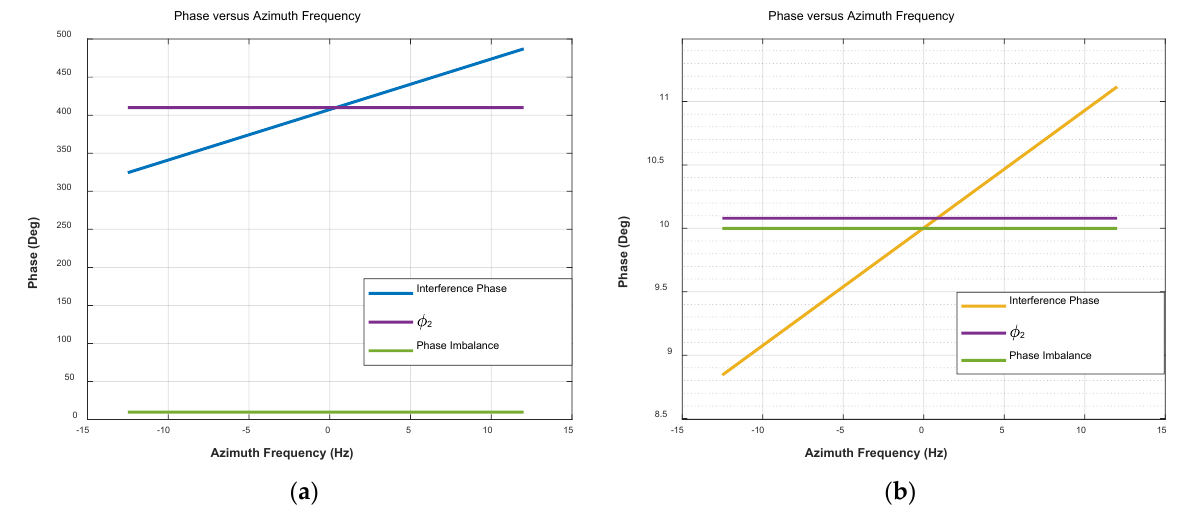
Figure 3. The phase imbalance estimation results by FCM before and after the Doppler centroid compensation, where the green line represents the actual phase imbalance, the blue line represents the interference phase between S 1 and S 2 calculated by Equation (13), and the purple line represents the estimation result of φ 2 by Equation (14). ( a ) The estimation results before the Doppler centroid compensation; ( b ) The estimation results after the Doppler centroid compensation.